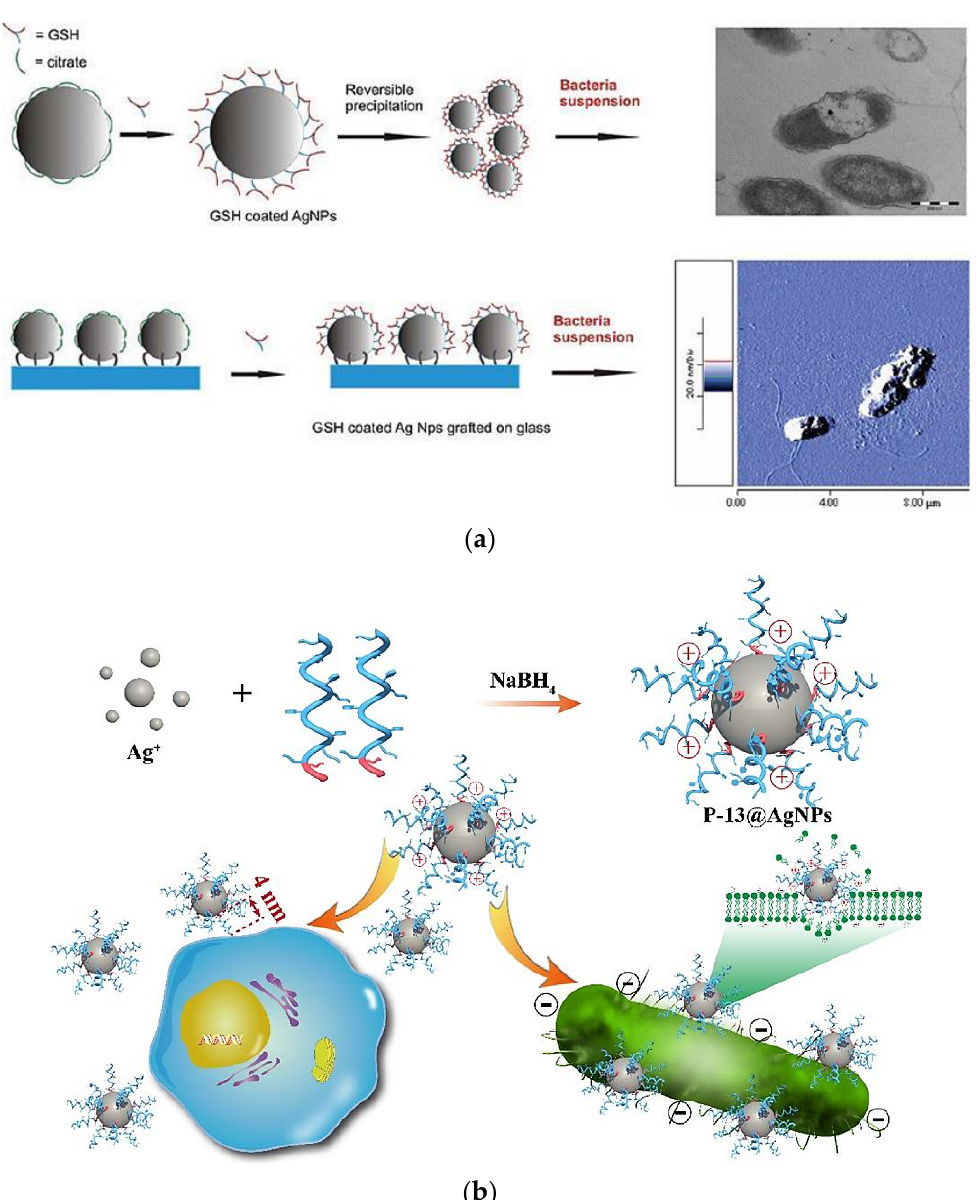
Figure 6. Examples of the result of the combination of peptides with AgNPs. ( a ) Schematic representation on GSH–AgNPs composite grafted on glass with TEM and AFM images of E.coli treated with GSH-coated NPs [255]. Reprinted with permission from Langmuir 2012, 28, 8140–8148. Copyright 2012 American Chemical Society. ( b ) Proposed mechanisms for reduced cytotoxicity and enhanced antimicrobial activity of P-13@AgNPs. Silver ions are reduced to AgNPs in presence of P-13 peptides using NaBH 4 as a reductant. The existing of P-13 between AgNPs and cells isolates the toxic Ag + from cells in the distance (theoretically ~4 nm, with a stretched peptide standing on the surface of AgNPs), which dramatically reduces the cytotoxicity effect on cells. In contrast, the P-13 peptides also endow highly positive charges on the surface of AgNPs, benefiting from the attracting interactions between P-13@AgNPs and negatively charged bacteria [257] Copyright 2020 Elsevier.